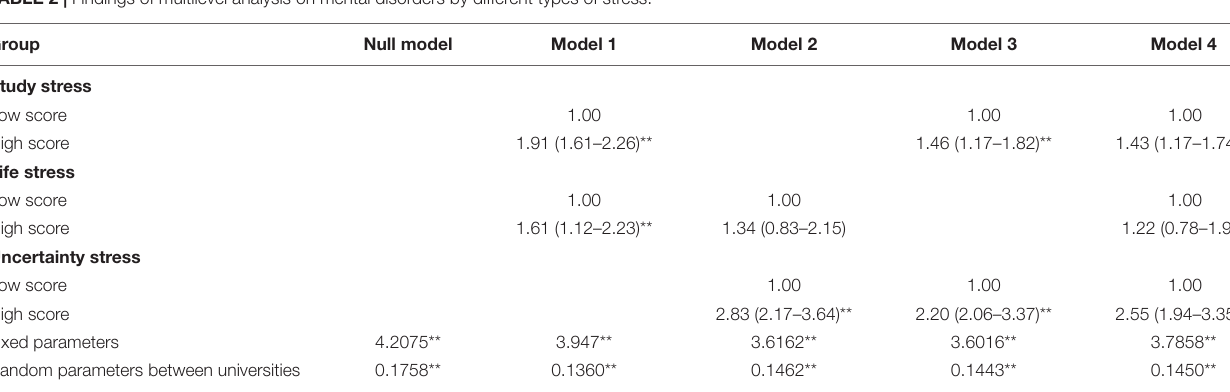
TABLE 2 | Findings of multilevel analysis on mental disorders by different types of stress.